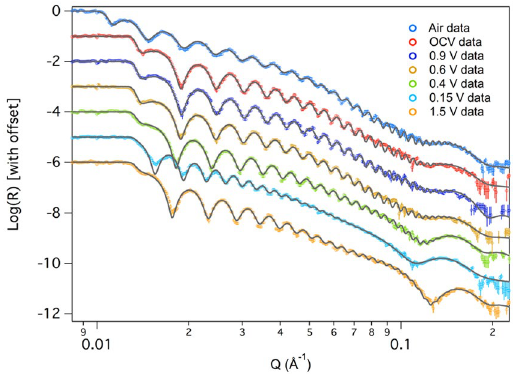
Figure 1. NR data (open data points) and fits (solid line) derived from the SLD profiles for representative data sets collected in this